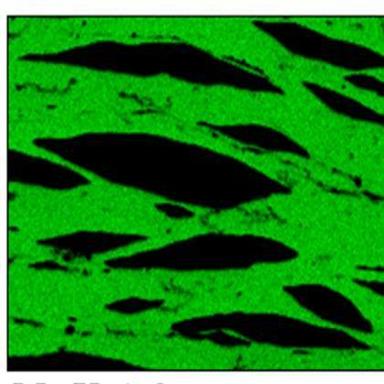
The EDS elemental mapping analysis results for the structure of accumulative fold-forged Mg/Ni composite material, indicating the composition of Mg-matrix and Ni-foil layers.